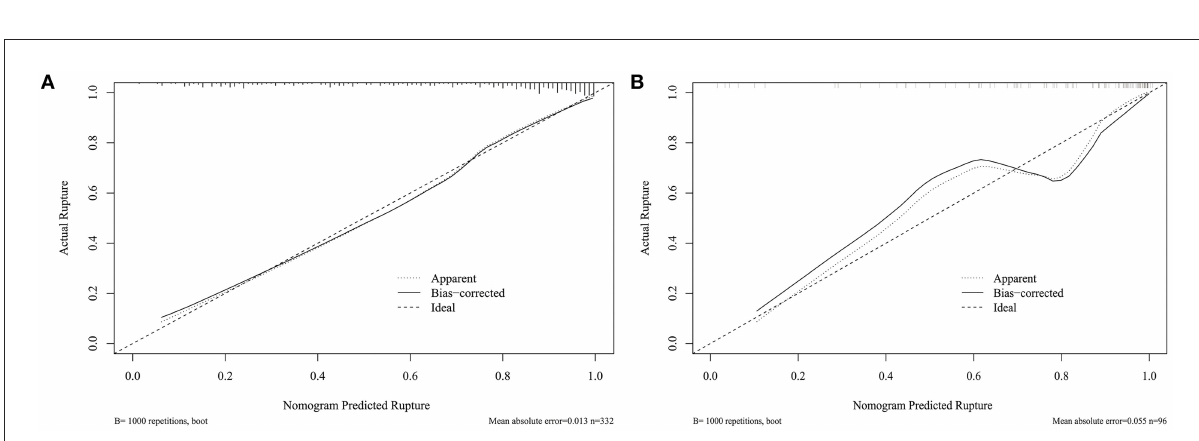
FIGURE5 Calibration curve for nomogram validation. (A) Internal validation. (B) External